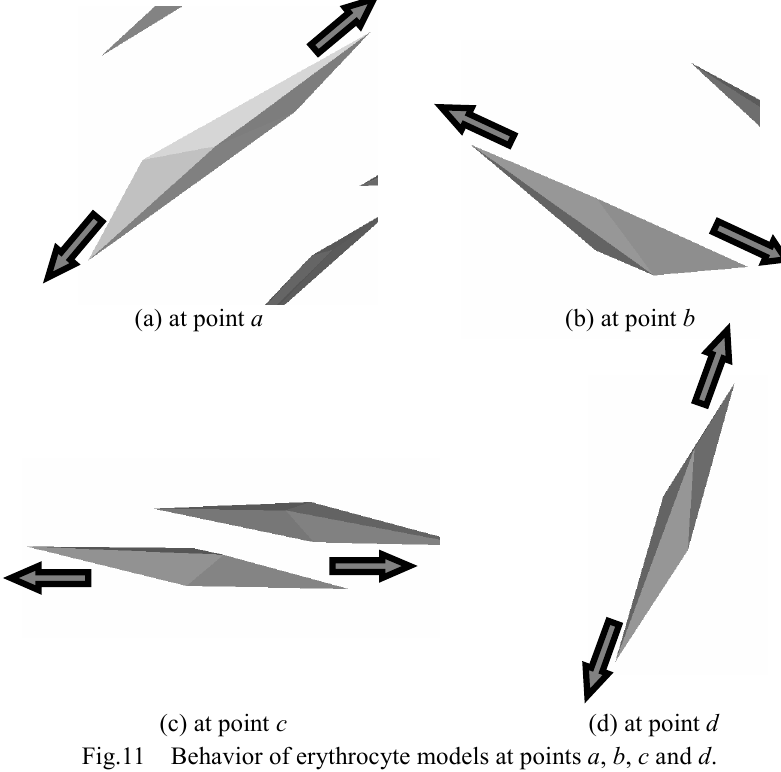
Fig.11 Behavior of erythrocyte models at points a , b , c and d